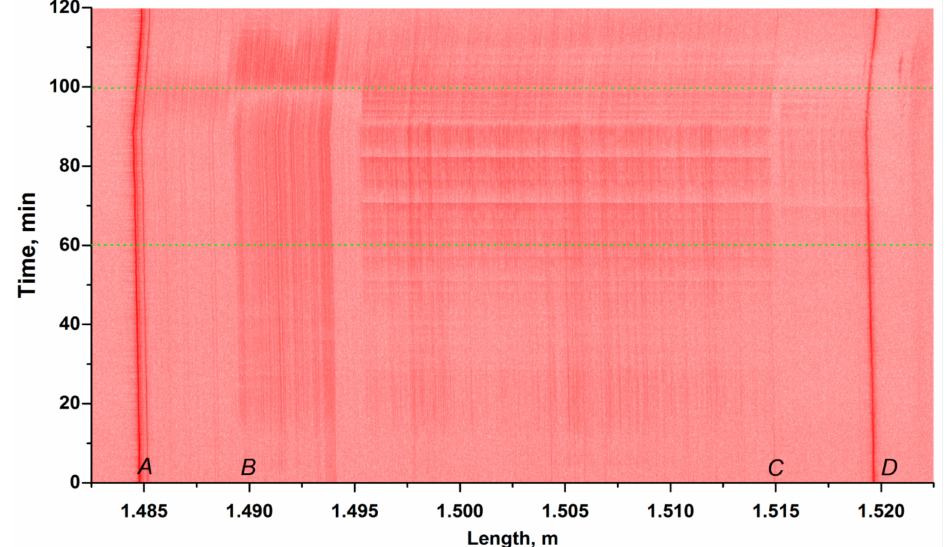
Figure 9. The temperature dynamics of the reflectograms. The locations A,B,C,D correspond to the key positions of IOM which are discussed